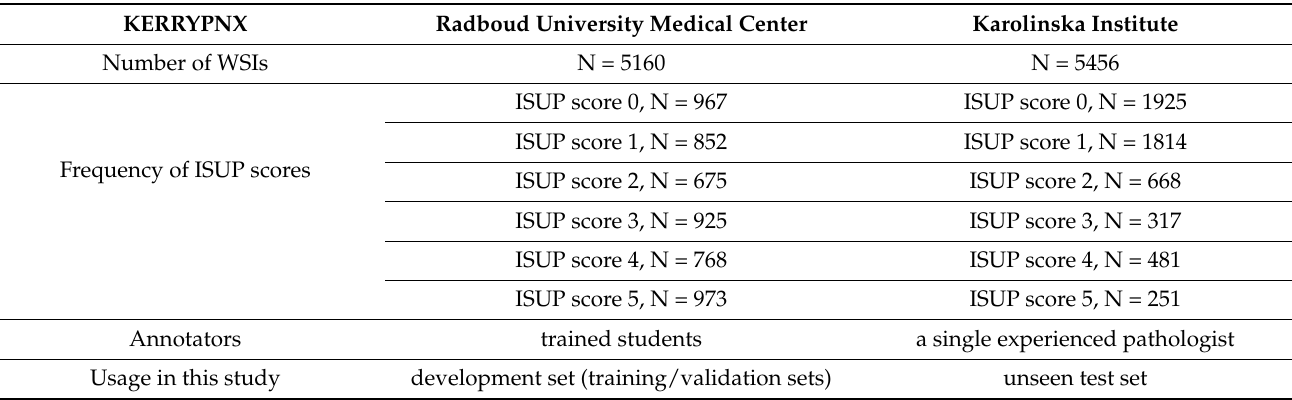
Table 2. Summary of the PANDA